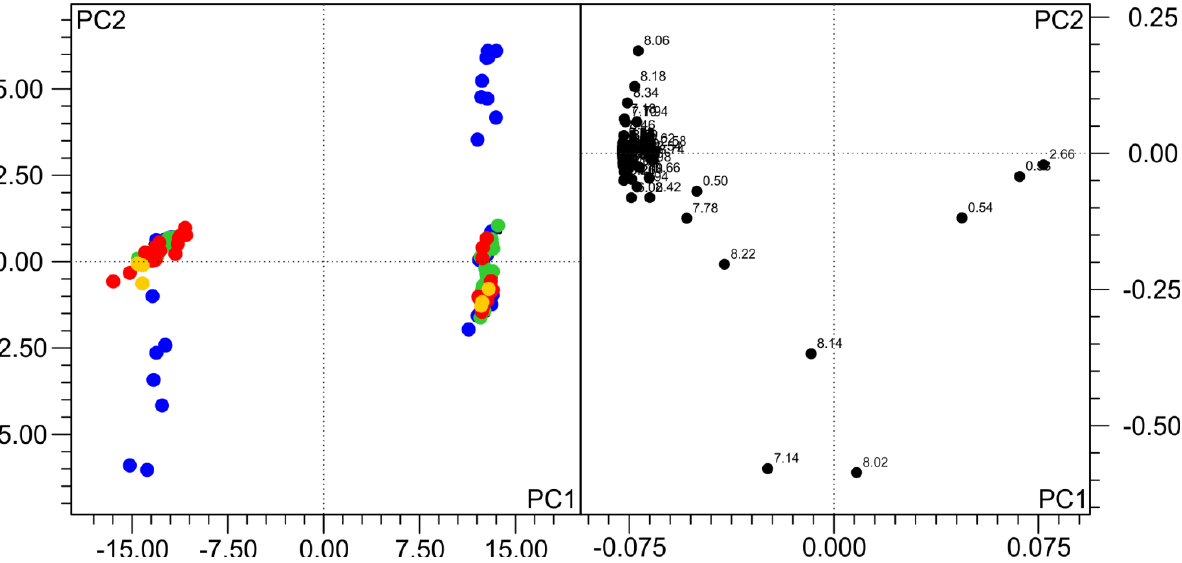
Figure 3. Principal component analysis (PCA) of 196 samples from the two volunteers frozen and stored under different conditions. Samples colored according to freezing temperature (for the legend, see Figure 1). Subjects are separated in the scores plot (left), but, also, samples frozen on dry ice are distinct from others. The loadings plot (right) shows the variables (bins) responsible for the separation. In the first two PCs > 96% of the variance in the data are explained. R2 = 0.976, Q2 = 0.959.